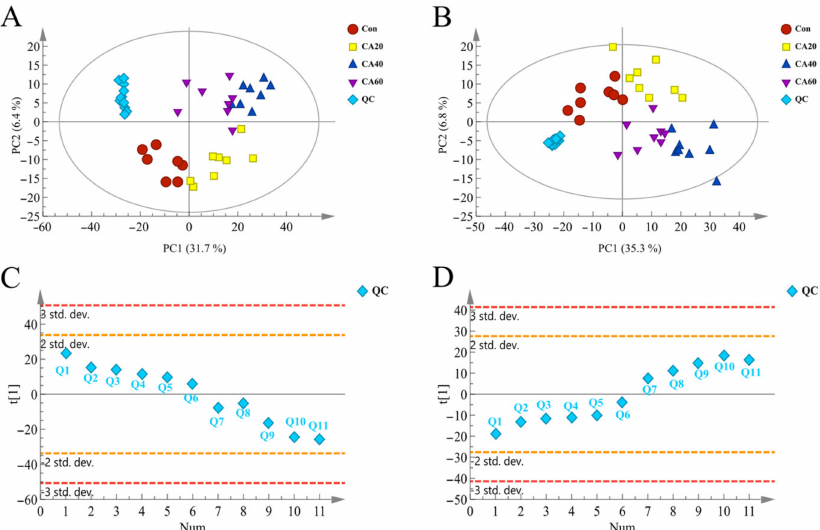
Figure 3. The PCA analysis of crucian carp kidney samples. ( A ) The PCA plot of positive ion mode. ( B ) The PCA plot of negative ion mode. ( C ) The standard deviation of QC samples in positive ion mode. ( D ) The standard deviation of QC samples in negative ion mode. Con represents the freshwater control group, CA20 represents the 20 mmol/L NaHCO 3 exposure group, CA40 represents the 40 mmol/L NaHCO 3 exposure group, and CA60 represents the 60 mmol/L NaHCO 3 exposure group. Orange and red lines indicate the 2 SD and 3 SD limits of peak height intensities,